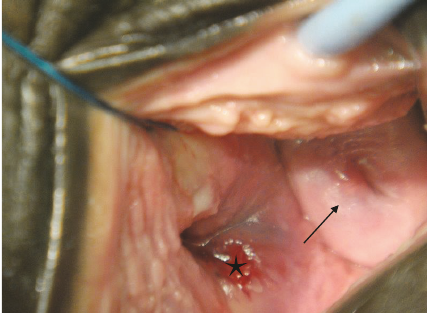
Figure 2: Showing the cervix (arrow) and adjacent residual tumor in the vagina (star) after the first incomplete